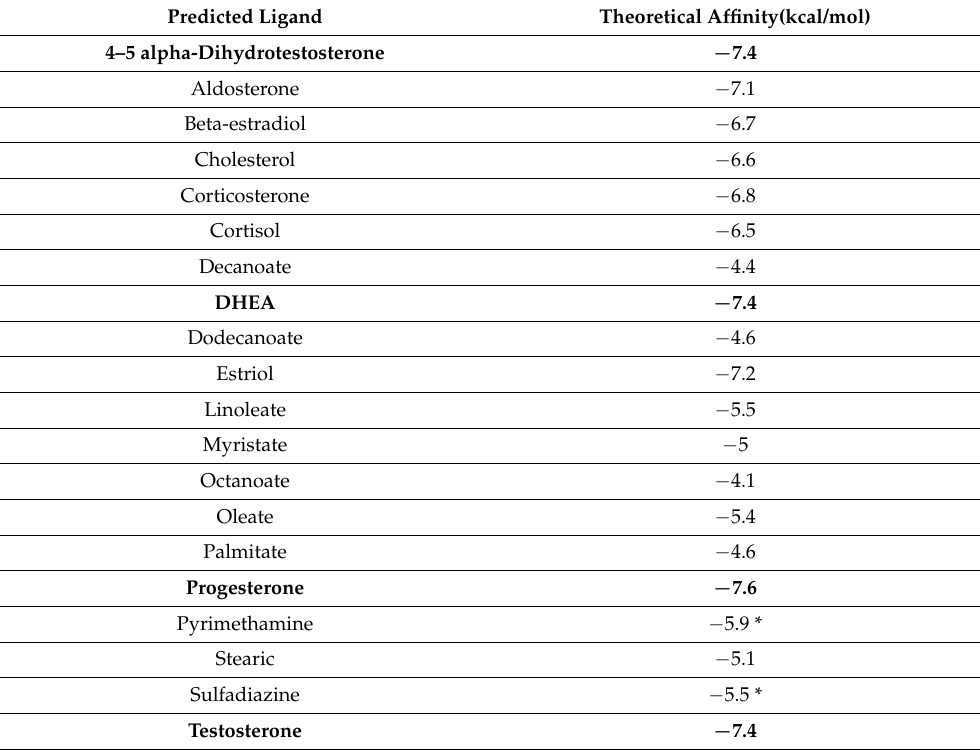
Figure 4. Model for T. gondii progesterone receptor membrane component (PGRMC) homolog and its docking to DHEA. The model for PGRMC contains a binding pocket for a heme group that functions as the binding site for DHEA. TYR158 binds the heme group on one face, while the other binds DHEA, blocking any interaction at that site. Table 2. Ligands that presented best affinities to Toxoplasma gondii